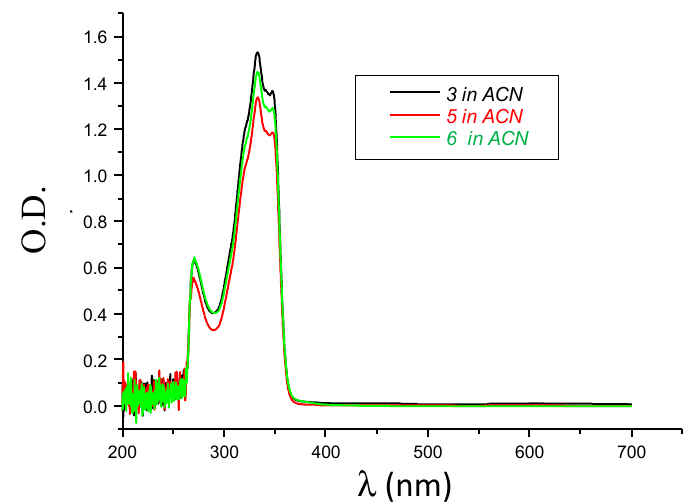
Figure 4. UV-vis absorption spectra for the most reactive iodonium salts ( 3 , 5 , and 6 ) in acetonitrile for a concentration of 1 × 10 − 4 M.